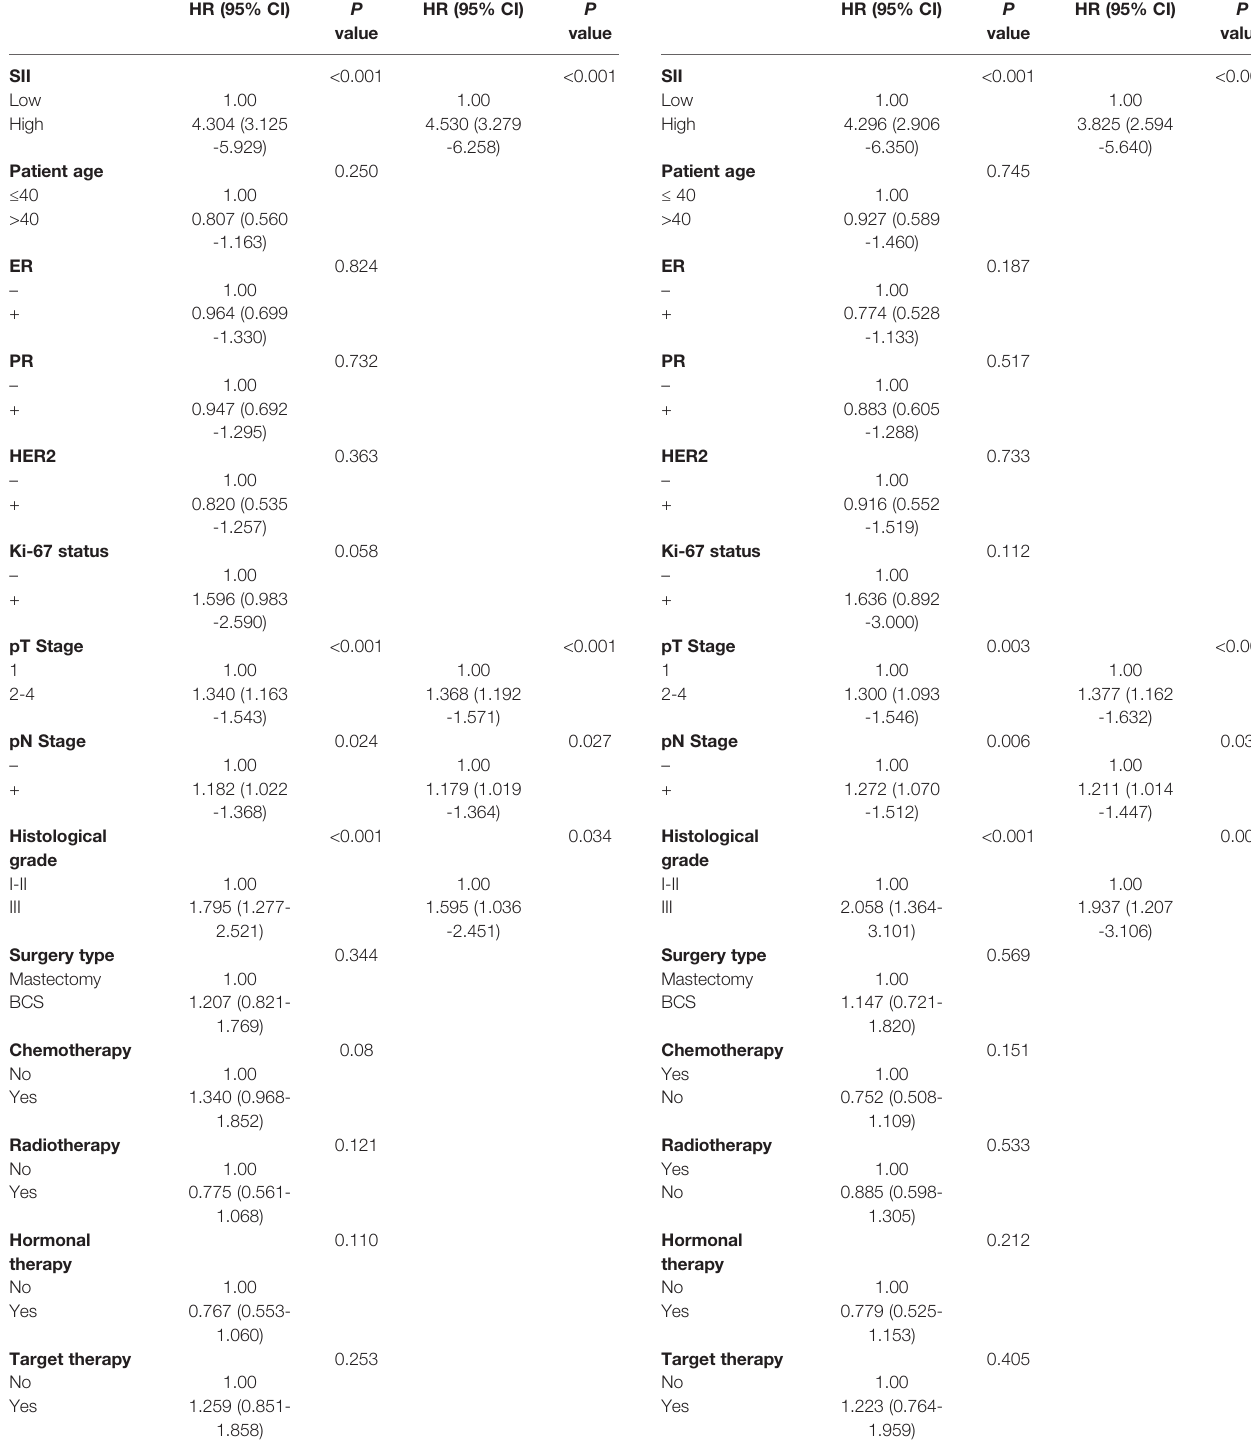
TABLE 2 | Results of the analysis of the prognostic factors for disease free survival. Univariate analysis